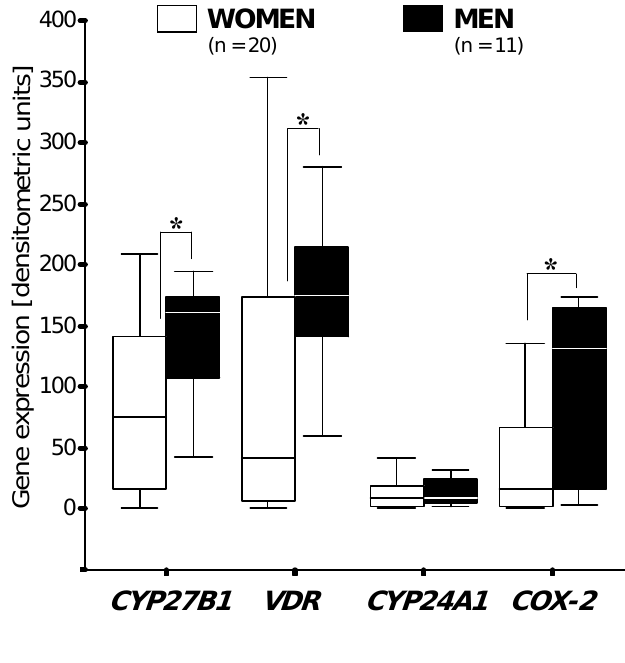
Figure 4. Gender-specific expression of VDR , CYP27B1 , CYP24A1 and COX- 2 mRNA in cancerous lesions in distal colon. Results of semi-quantitative PCR (see Methods) are shown as boxplots of medians (from n patients per group). Asterisk indicates statistical significance (*, p <